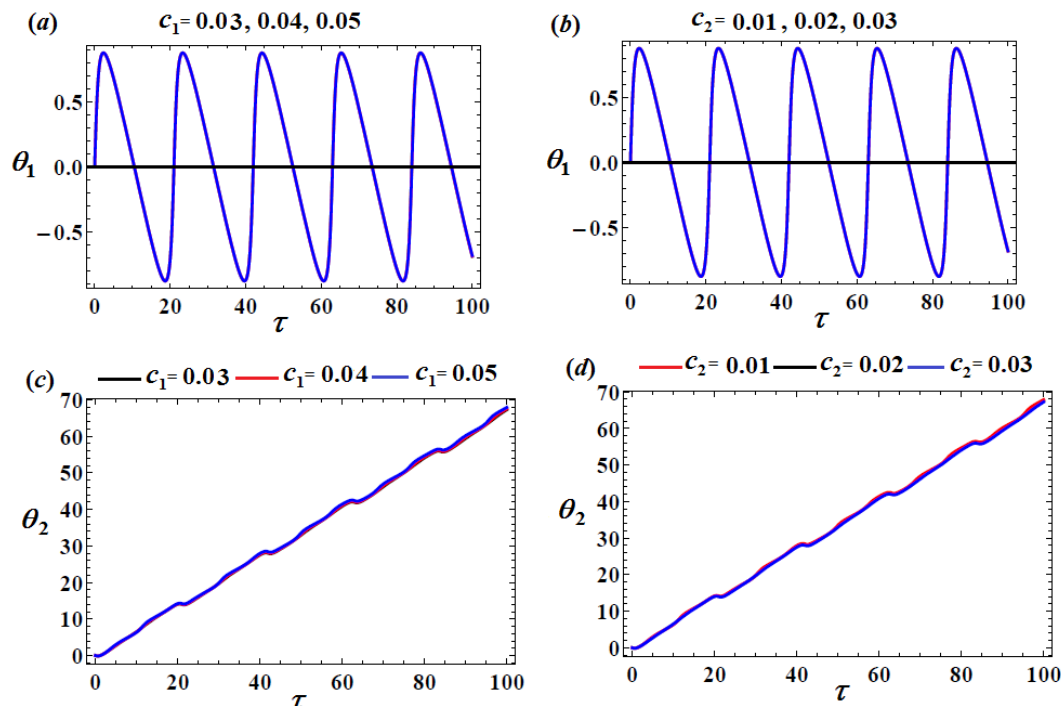
tudes a and b with regard to the horizontal elongation  and the rotation angle  , respectively.